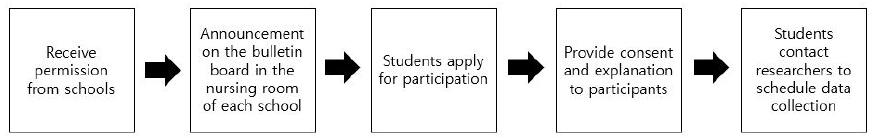
Figure 1. Flowchart of the participants’ recruitment.